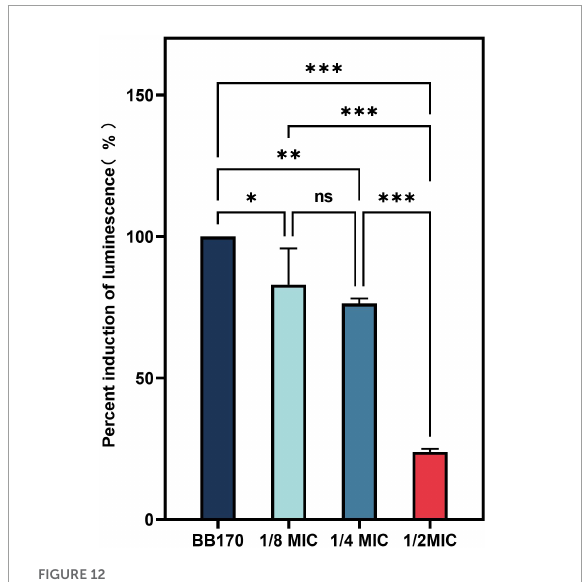
FIGURE12 The effect of chlorogenic acid (CA) on the percent induction of luminescence of Vibrio harveyi . “ ∗ ” Means P < 0.05, “ ∗∗ ” means P < 0.01, “ ∗∗∗ ” means P < 0.001, and “ns” means P >